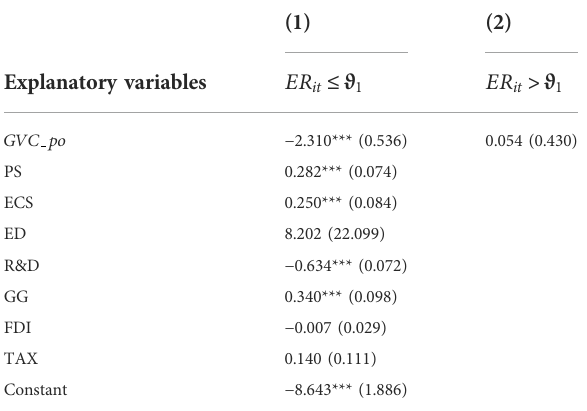
TABLE 9 Threshold model regression